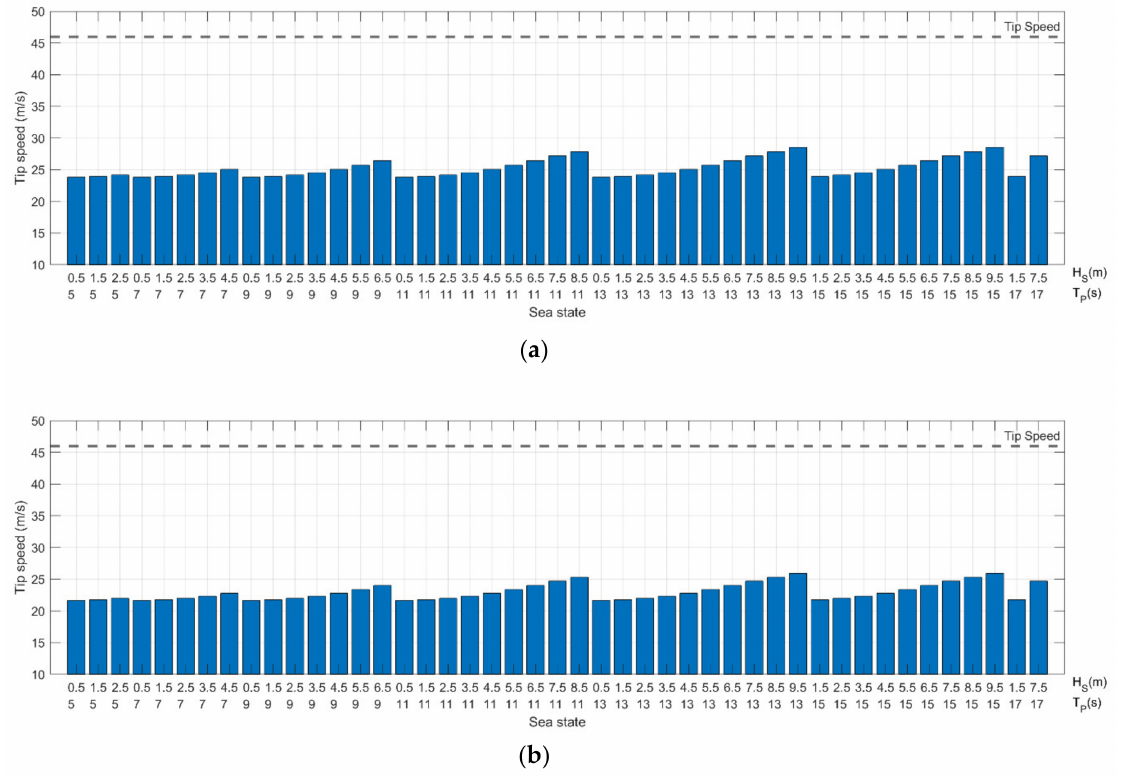
Figure 11. Variation of tip speed for different sea states. ( a ) no cup, ( b ) heavy